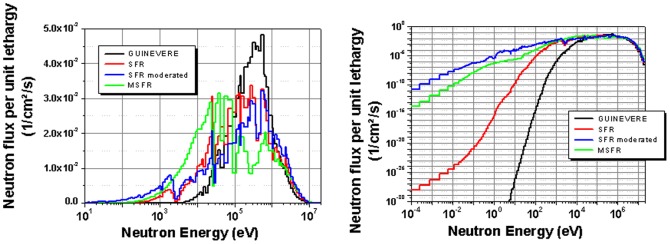
Comparison of the neutron spectrum in different fast reactor systems.